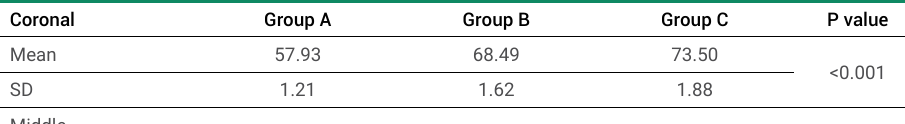
Table 2. Mean and Standard deviation (SD) and the results of ANOVA test for comparison of push-out (MPa) in the coronal, middle and apical thirds between the three groups: